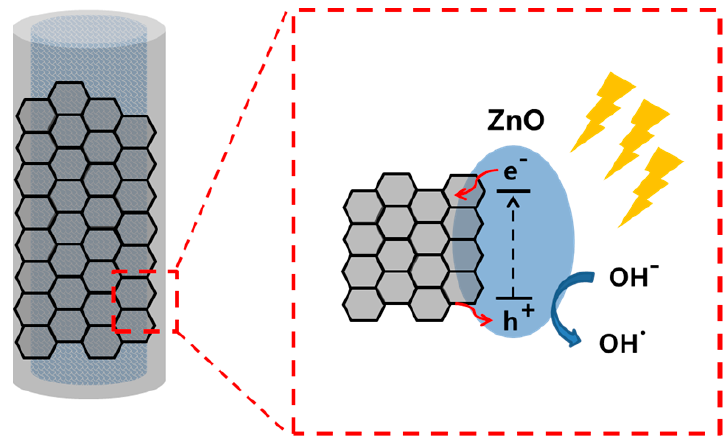
Figure 4. Schematic diagram showing the internal structure and mechanism of degradation.